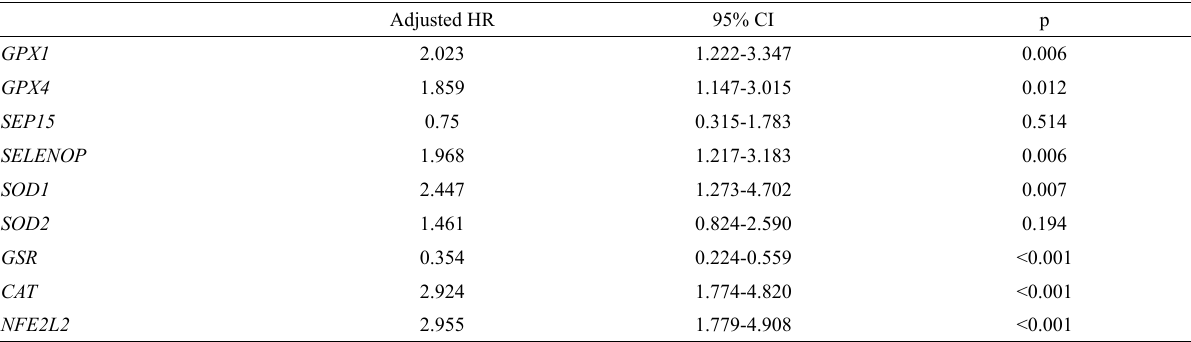
Table 2 – Multivariate Cox proportional hazards regression analysis to assess the independent effect of gene expression on survival in 12 months